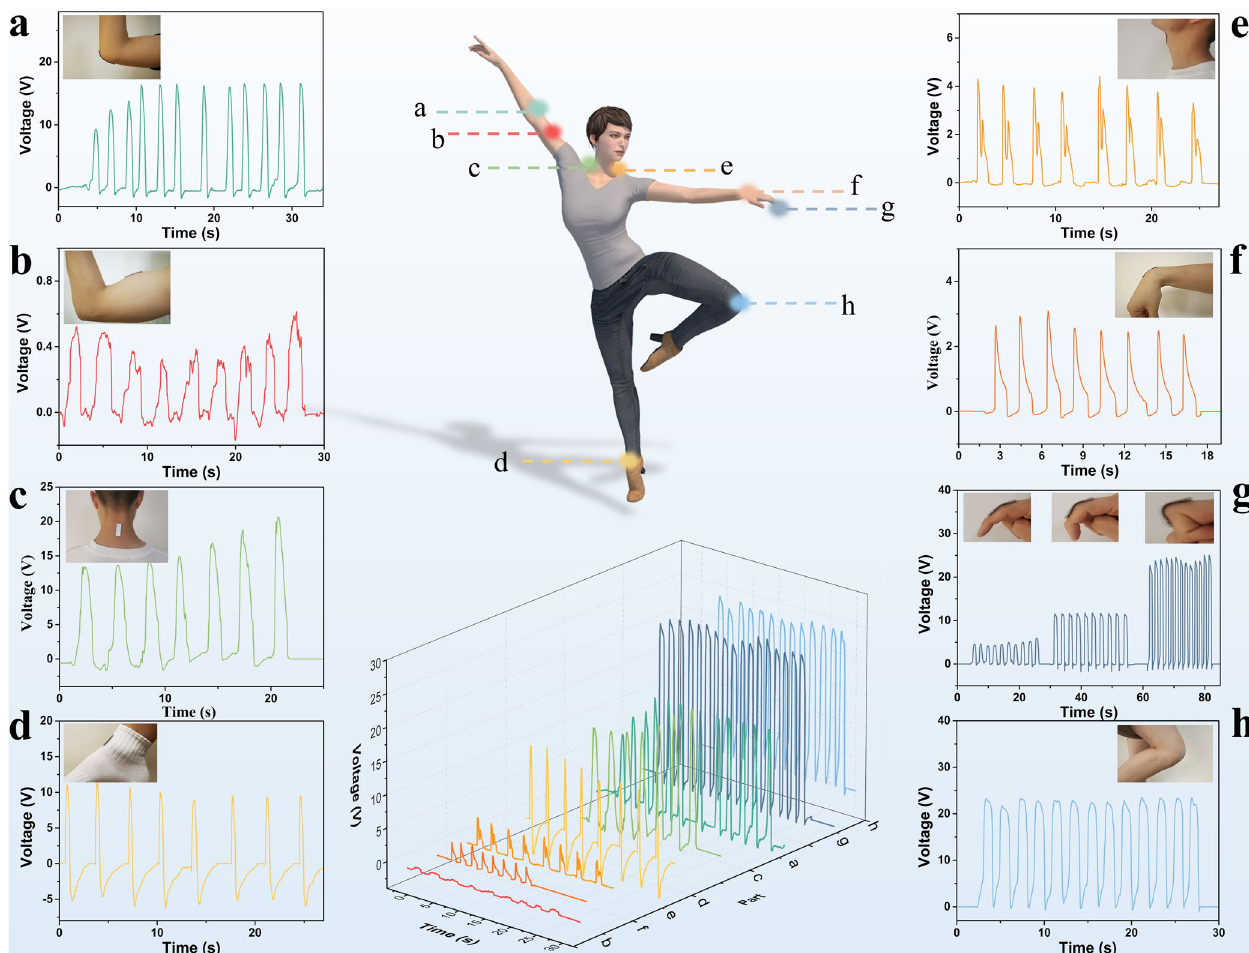
Fig. 5 Potential application of the triboelectric sensor. Real-time monitoring of human movements using AF@VMT-5 paper-based TENG. a Voc signals generated by elbow bending. b Voc signals generated by biceps fi ring. c Voc signals generated when raising and lowering the head. d Voc signals generated when fl exing the ankle. e Voc signals generated by throat swallowing. f Voc signal generated by wrist movements. g Voc signals generated when the fi ngers are bent at different angles. h Voc signals generated during knee fl exion